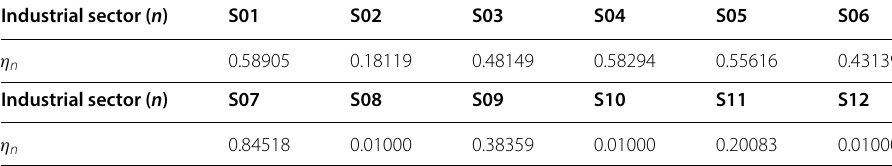
Table 3 Estimation of substitution parameter of Armington function, η n Industrial sector ( n )